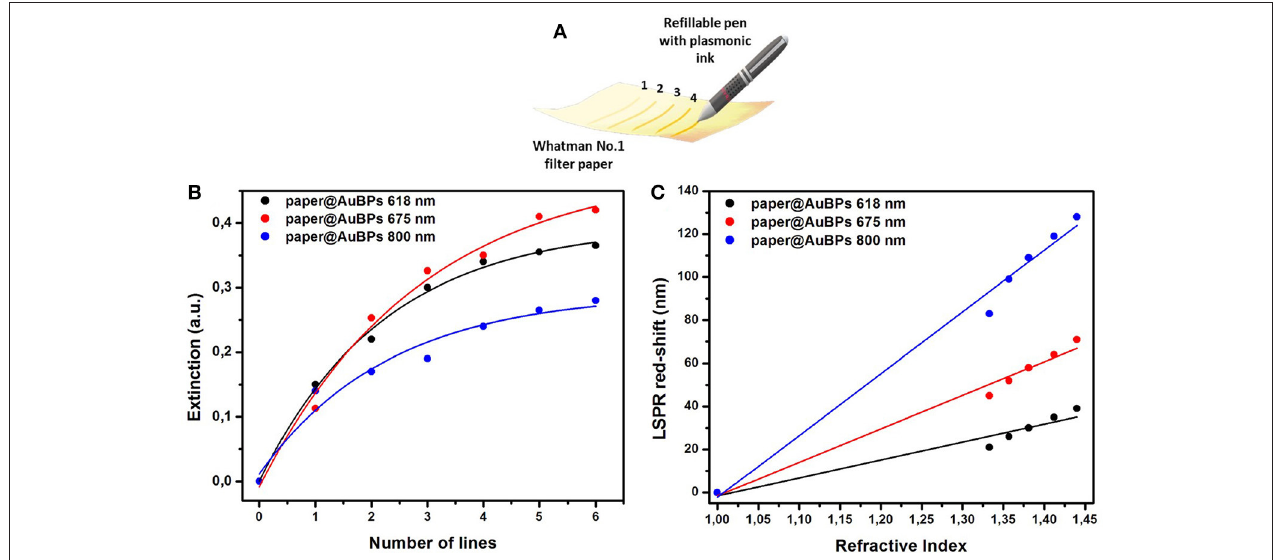
FIGURE 3 | Schematic illustration of the drawing process employing commercial pen filled with AuBPs as colloidal ink in order to calligraph different numbers of re-traced plasmonic lines (A) ; Dependence of the extinction intensity of the longitudinal LSPR band of the previously designed paper@AuBPs 618–black plot, paper@AuBPs 675–red plot, and paper@AuBPs 800–blue plot, as function of number of plasmonic lines traced (B) ; Plots depicting the linear dependence of the longitudinal LSPR position on the bulk refractive index for the tunable plasmonic paper based nanoplatforms, i.e., paper@AuBPs 618, paper@AuBPs 675, paper@AuBPs 800, respectively (C)